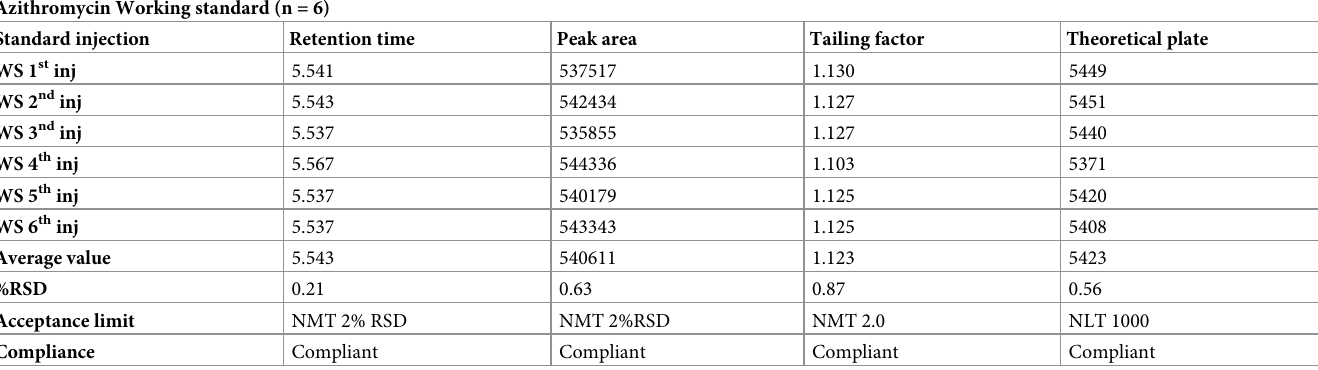
Table 9. System suitability test results for chromatographic method for dissolution of Azithromycin tablet. Azithromycin Working standard (n = 6)